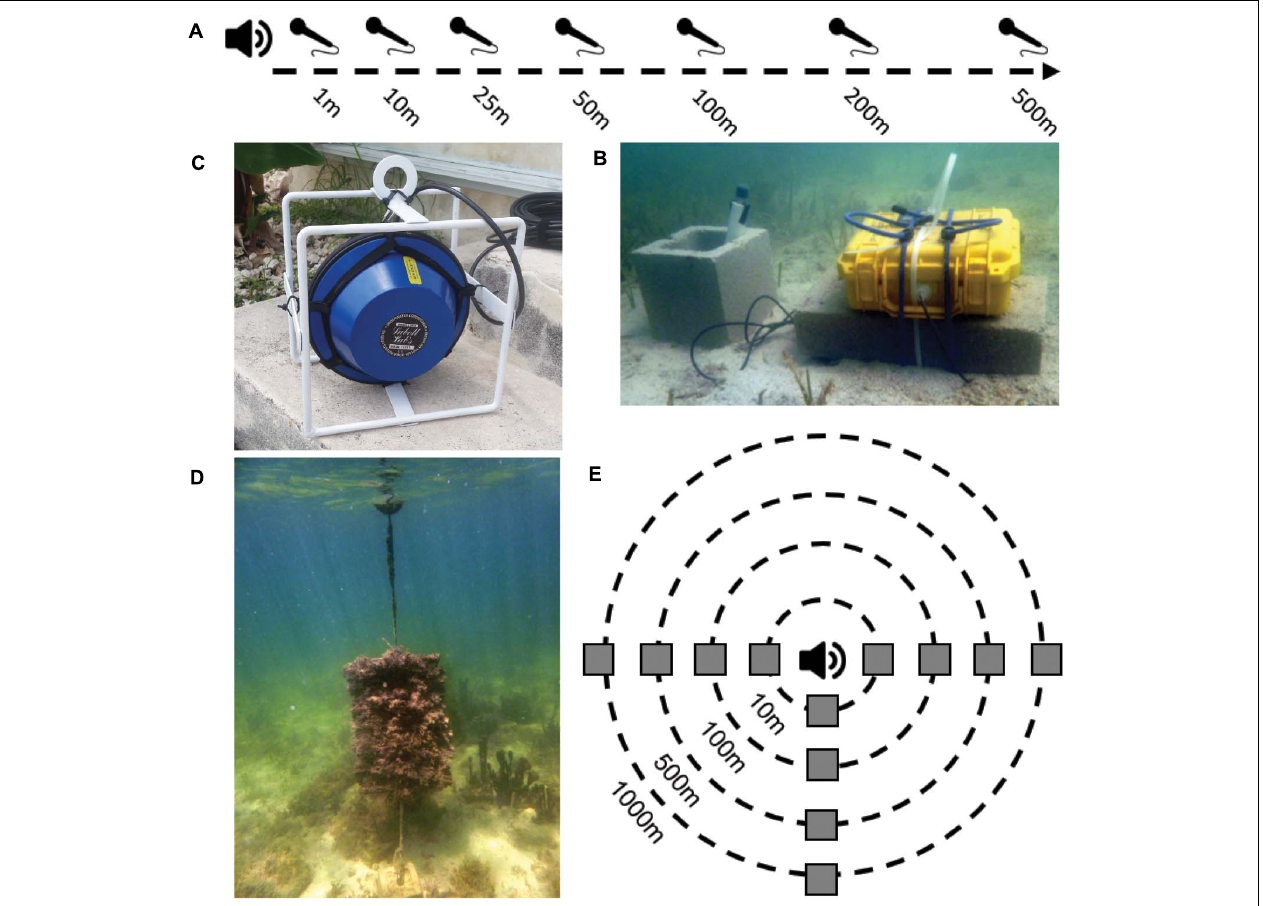
FIGURE 2 | Graphics and photos describing experimental set-ups and equipment. (A) Graphical depiction of the transmission loss experimental set up with hydrophones set up at 1, 10, 25, 50, 100, 200, and 500 m from the sound source. (B) Underwater photo of Aquarian Audio H2a omnidirectional hydrophones attached to Roland Edirol R-05 or R-07 solid-state WAV recorders contained in a waterproof housing (photo credit: Jack Butler). (C) Photo of the underwater speaker. (D) Photo of a larval collector made of frayed rope attached to a mesh back with 3/4 in PVC pipe top and bottom frame and tethered to a buoy and anchor made of cement blocks (photo credit: Jack Butler). (E) Graphical depiction of experimental set-up to test larval attraction to sound at different distances. Three artificial larval collectors (gray squares) were deployed at four distances (10, 100, 500, and 1,000 m) from an omnidirectional underwater speaker system (at center) broadcasting either healthy or degraded hardbottom